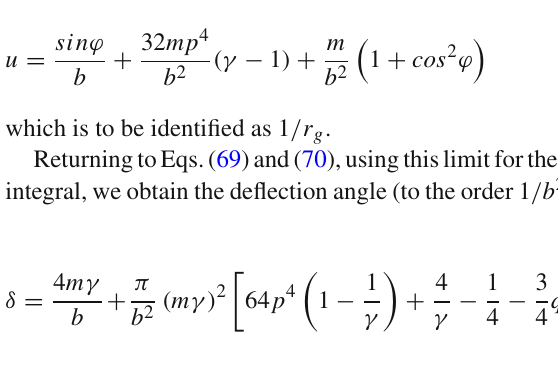
Fig. 13 Overlapping plots of the bending angle δ against normalized radial distance x for compact stars given in Table 1, for different values of the parameter γ . Plots are generated for the stationary state of uncharged ZV